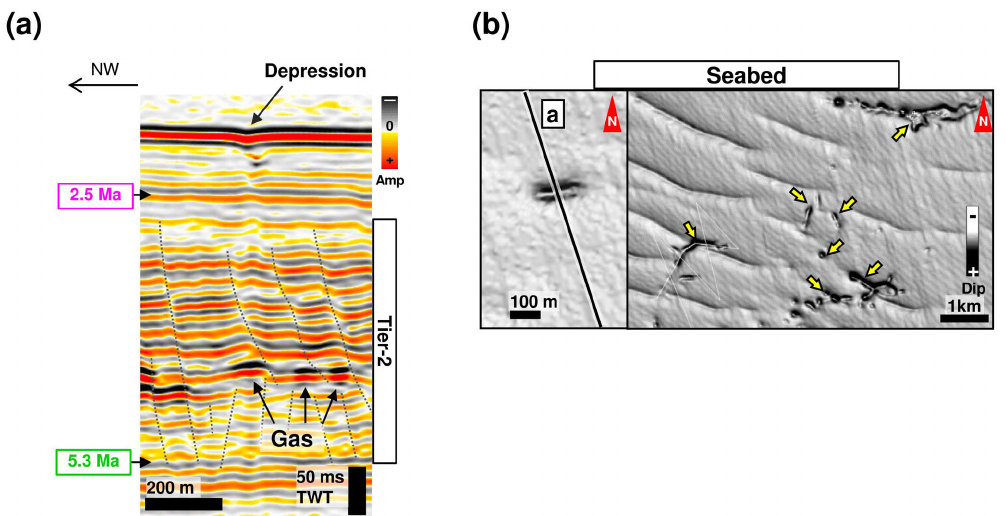
Figure 7. Dip map showing linear depressions at the present day seafloor. (a) Seismic section shown in map (b) is across one depression, which occurs at the topmost termination of a Linear Chimney emanating from Tier-1. (b) The linear depressions at issue are indicated by yellow arrows and locally interfere with regularly spaced furrows likely of sedimentary